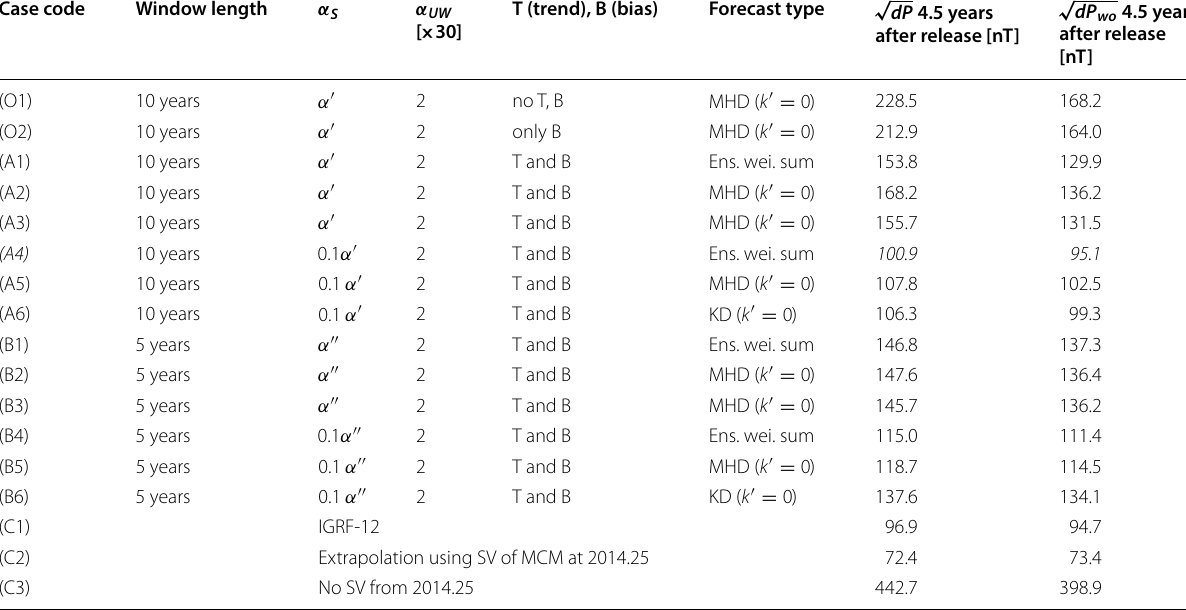
Table 1 Summary of the numerical